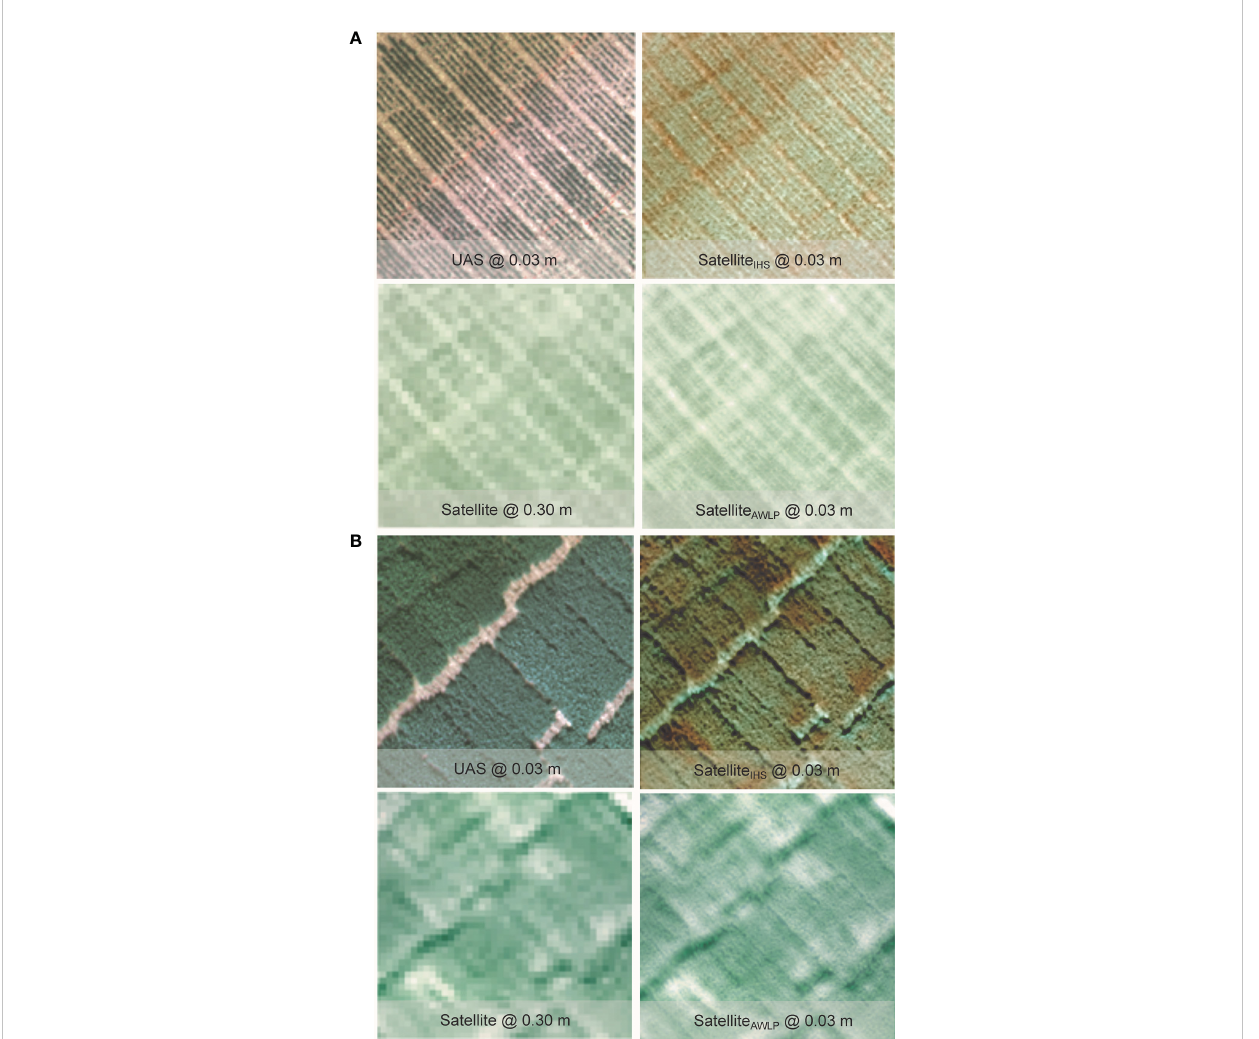
FIGURE 7 Visual comparison of RGB from the original satellite and UAS imagery, and pan-sharpened satellite imagery generated using intensity-hue-saturation (IHS) and additive wavelet luminance proportional (AWLP) approaches from Site 2 at TP 1 (A) and TP 2 (B) .